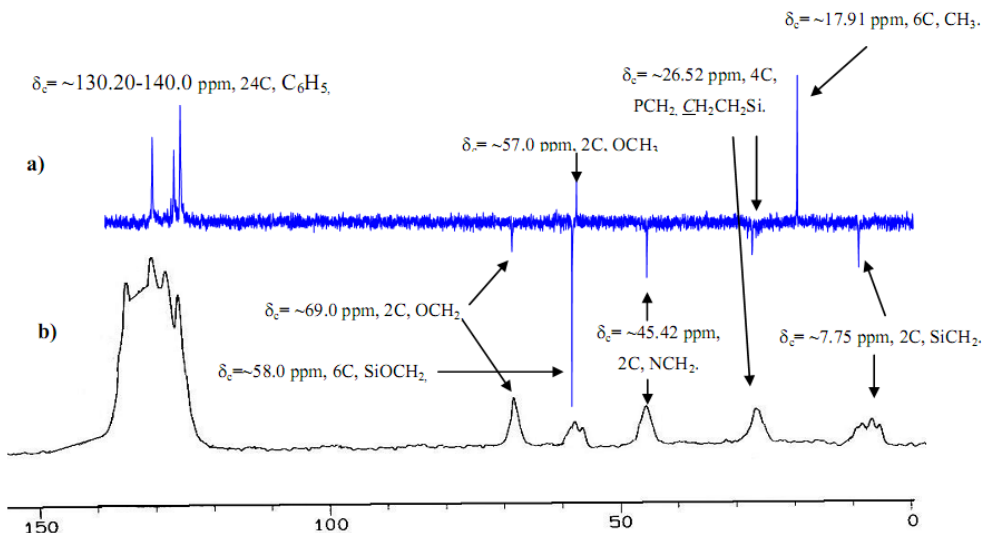
Figure 5. 1 Dept 135 13 C-NMR of complex 1 in CDCl MAS-NMR X1 xerogels